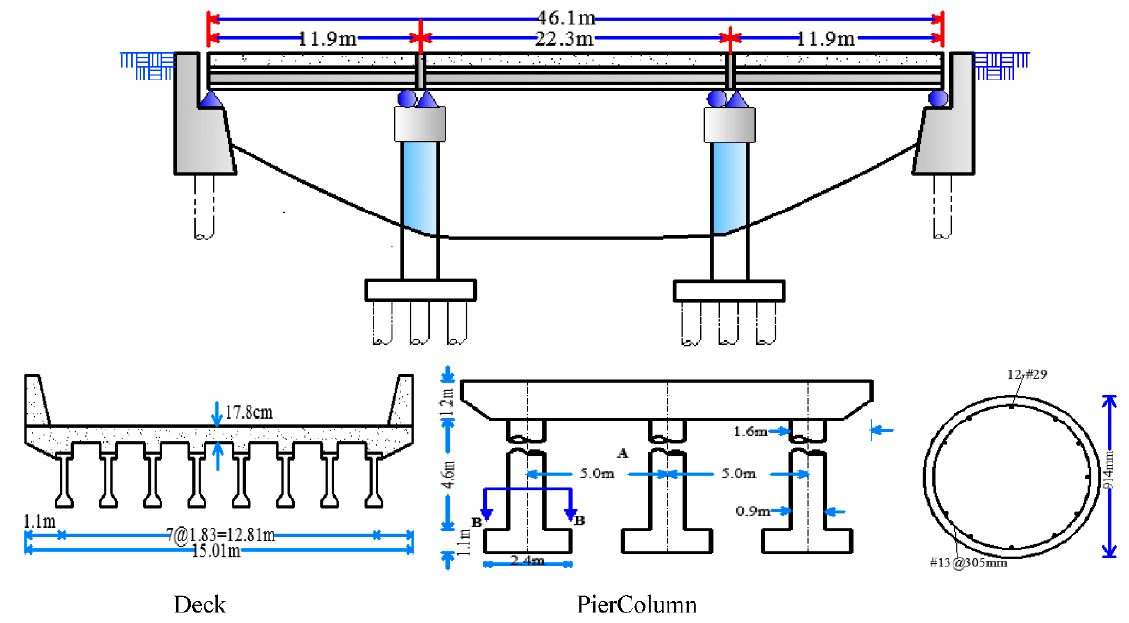
Figure 1. Case study multi-span continuous (MSC) concrete girder bridge.